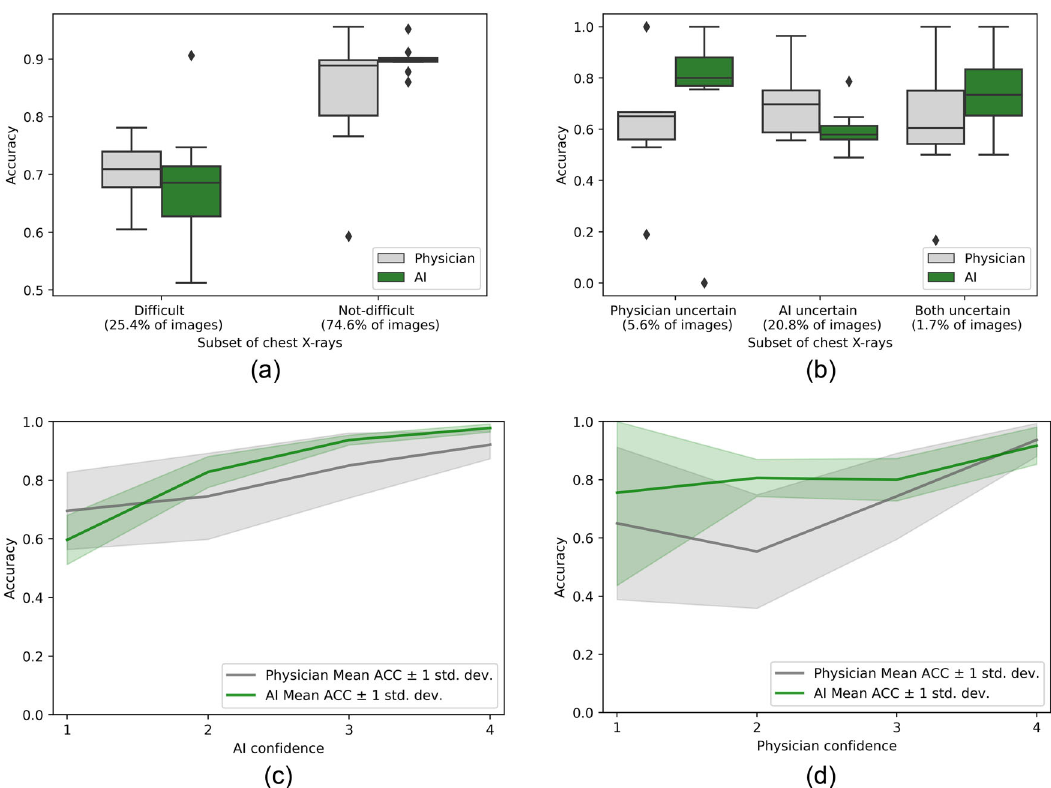
Fig. 1 Performance of physicians and the AI model strati fi ed on dif fi culty and certainty levels. a Compares the performance of physicians and AI performance strati fi ed on the dif fi culty of the image interpretation, b compares the performance of physicians and AI strati fi ed on uncertainty in their evaluation, and c , d show physician and AI accuracy strati fi ed on their respective con fi dence levels. The physician accuracies were calculated by comparing each of the nine physicians against reference labels that were generated from the remaining eight physicians. Similarly, the AI accuracies were composed of nine values by comparing the AI model output against the same nine sets of reference labels that physicians were tested against. Bootstrapping was not used to generate Fig. 1. ACC accuracy, std. dev. standard